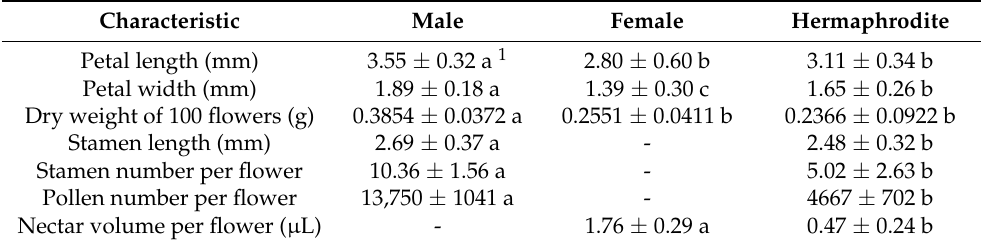
Table 1. Floral morphology and rewards. Comparing male, female, and hermaphrodite flowers. Characteristic